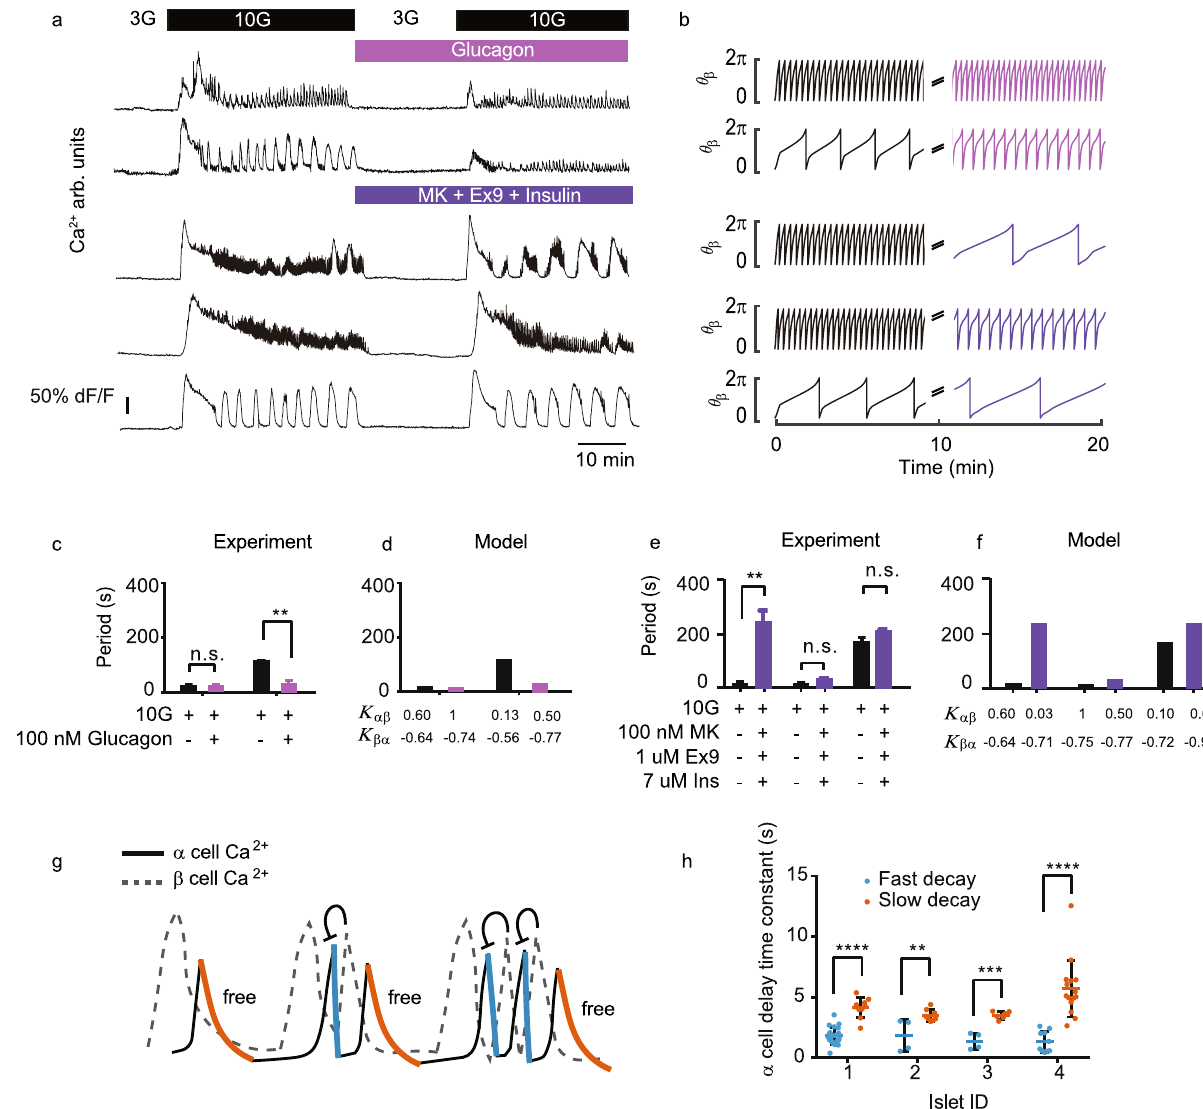
Fig. 7 Model predictions and experimental support. a Top two rows: Mean β cell Ca 2 + signal ( Glu-Cre + ;GCaMP6f f/ + ; Ins2 - RCaMP1.07 islet, see Supplementary Fig. 8a for both α and β signals). The stimulation is 3 G (10 min), 10 G (40 min), 3 G + 100 nM glucagon (20 min) and 10 G + 100 nM glucagon (35 min). Bottom three rows: Mean β cell Ca 2 + signal ( Ins + /- ;GCaMP6f f/ + islet). The stimulation is 3 G (10 min), 10 G (40 min), 3 G + 100 nM MK (MK0893) + 1 uM Ex9 (Exendin (9 – 39)) + 7 uM insulin (20 min) and 10 G + 100 nM MK + 1 uM Ex9 + 7 uM insulin (35 min). b Modeling parameters in the fi rst row: K αβ = 0.60, K βα = − 0.64 for 0 – 10 min, and K αβ = 1, K βα = − 0.74 for 10 – 20 min. Second row: K αβ = 0.13, K βα = − 0.56 for 0 – 10 min and K αβ = 0.5, K βα = − 0.77 for 10 – 20 min. Third row: K αβ = 0.60, K βα = − 0.64 for 0 – 10 min and K αβ = 0.03, K βα = − 0.71 for 10 – 20 min. Fourth row: K αβ = 1, K βα = − 0.75 for 0 – 10 min and K αβ = 0.50, K βα = − 0.77 for 10 – 20 min. Fifth row: K αβ = 0.10, K βα = − 0.72 for 0 – 10 min and K αβ = 0.04, K = − 0.90 for 10 – 20 min. c Mean Ca 2 + oscillation period (n = 4 fast-to-fast and 3 slow-to-fast islets from 3 mice in 3 independent isolations). Bars βα represent mean ± s.d. d Mean period from the model in the top two rows of b . e Mean Ca 2 + oscillation period ( n = 5 fast-to-slow, 4 fast-to-fast and 5 slow- to-slow islets from 4 mice in 4 independent isolations). Bars represent mean ± s.d. f Mean period from the model in the bottom three rows of b . g Schematic of α (solid) and β (dashed) cell mix Ca 2 + trace in islet. The fast (orange) and slow (blue) α cell transients. h The decay time constants (see Supplementary Fig. 3 for the de fi nition) for the fast (orange) and slow (blue) α cell transients described in g in mixed oscillations (4 islets). Bars represent mean ±